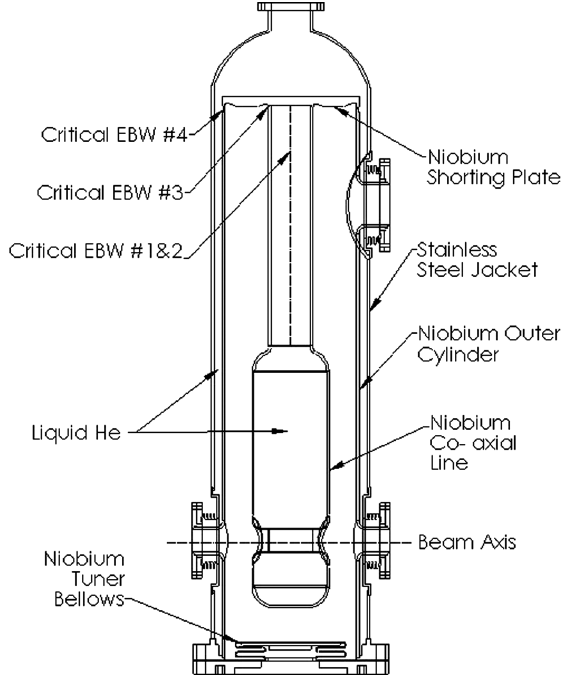
FIG. 2. Schematic diagram of the IUAC QWR. The overall height of the resonator is about 80 cm. The critical welds in the high magnetic field region of the resonator are indicated. Welds #1 and 2 are long seam butt joints on the upper section of the coaxial line; the first weld is on the front side and the second weld is on the back side. Welds #3 and 4 are both step